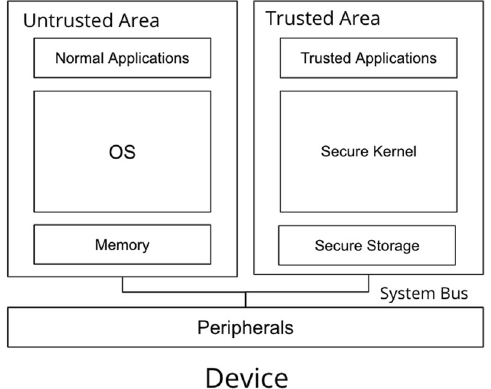
Fig. 3 TEE with co-existing execution environments. The trusted area on the right-hand side includes all trusted components used for executing trusted functions. Everything outside the trusted area are treated to be